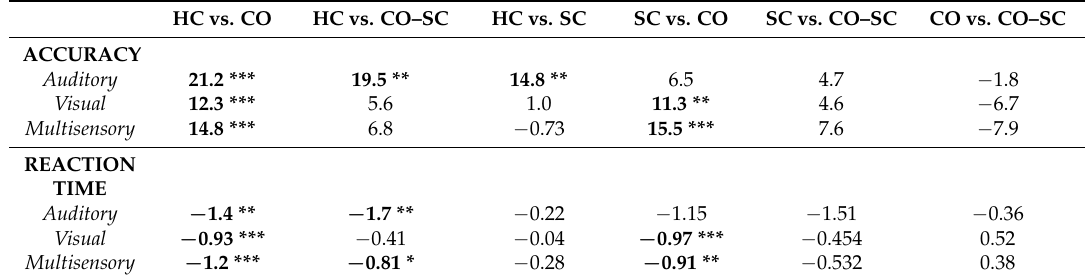
Table 5. Mean group differences for naming accuracy and correct reaction time across